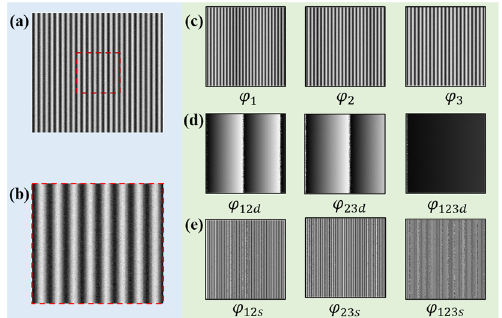
Figure 5. Simulation of the process from fringes to phases. ( a ) Fringe patterns with noise. ( b ) Enlarged image of the boxed area. ( c ) The phases obtained by the PSP. ( d ) Phase difference maps. ( e ) Phase sum maps.